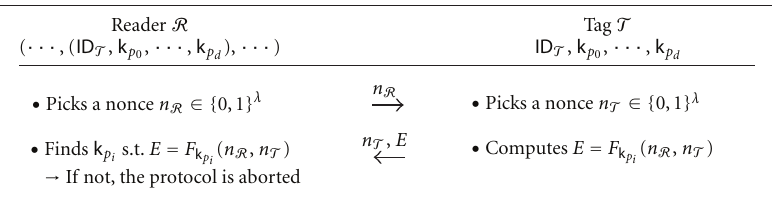
F 2: One round of the tree-based authentication